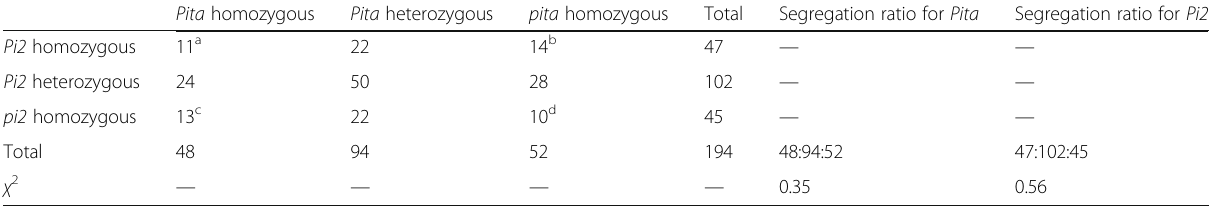
Table 2 Results of genotypes based on Ind306 and Pita -based marker among the 194 Pi46 homozygous plants Pita homozygous